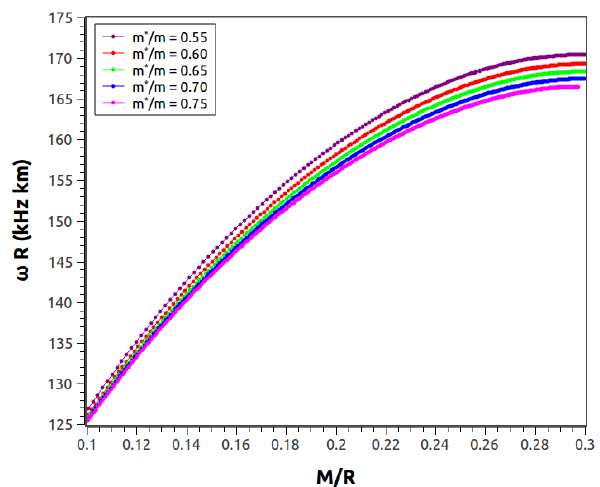
Figure 13. Scaled f -mode frequency ω R (in kHz km) as function of stellar compactness C = M / R for varying m ∗ / m